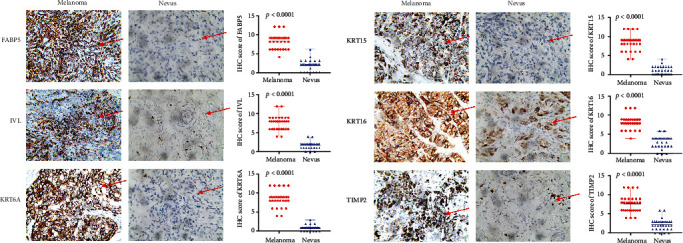
(a) IHC staining indicated significantly elevated FABP5, IVL, KRT6A, KRT15, KRT16, and TIMP2 expressions in terms of density and intensity in melanoma tissues compared with nevus tissues. All melanocyte contents were shown in red arrows. (b) Scatter plots of IHC score between melanoma and nevus tissues were illustrated (p < 0.0001).